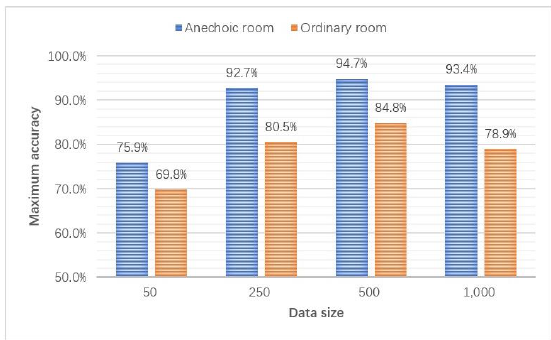
Figure 10: The result is compared after changing the data